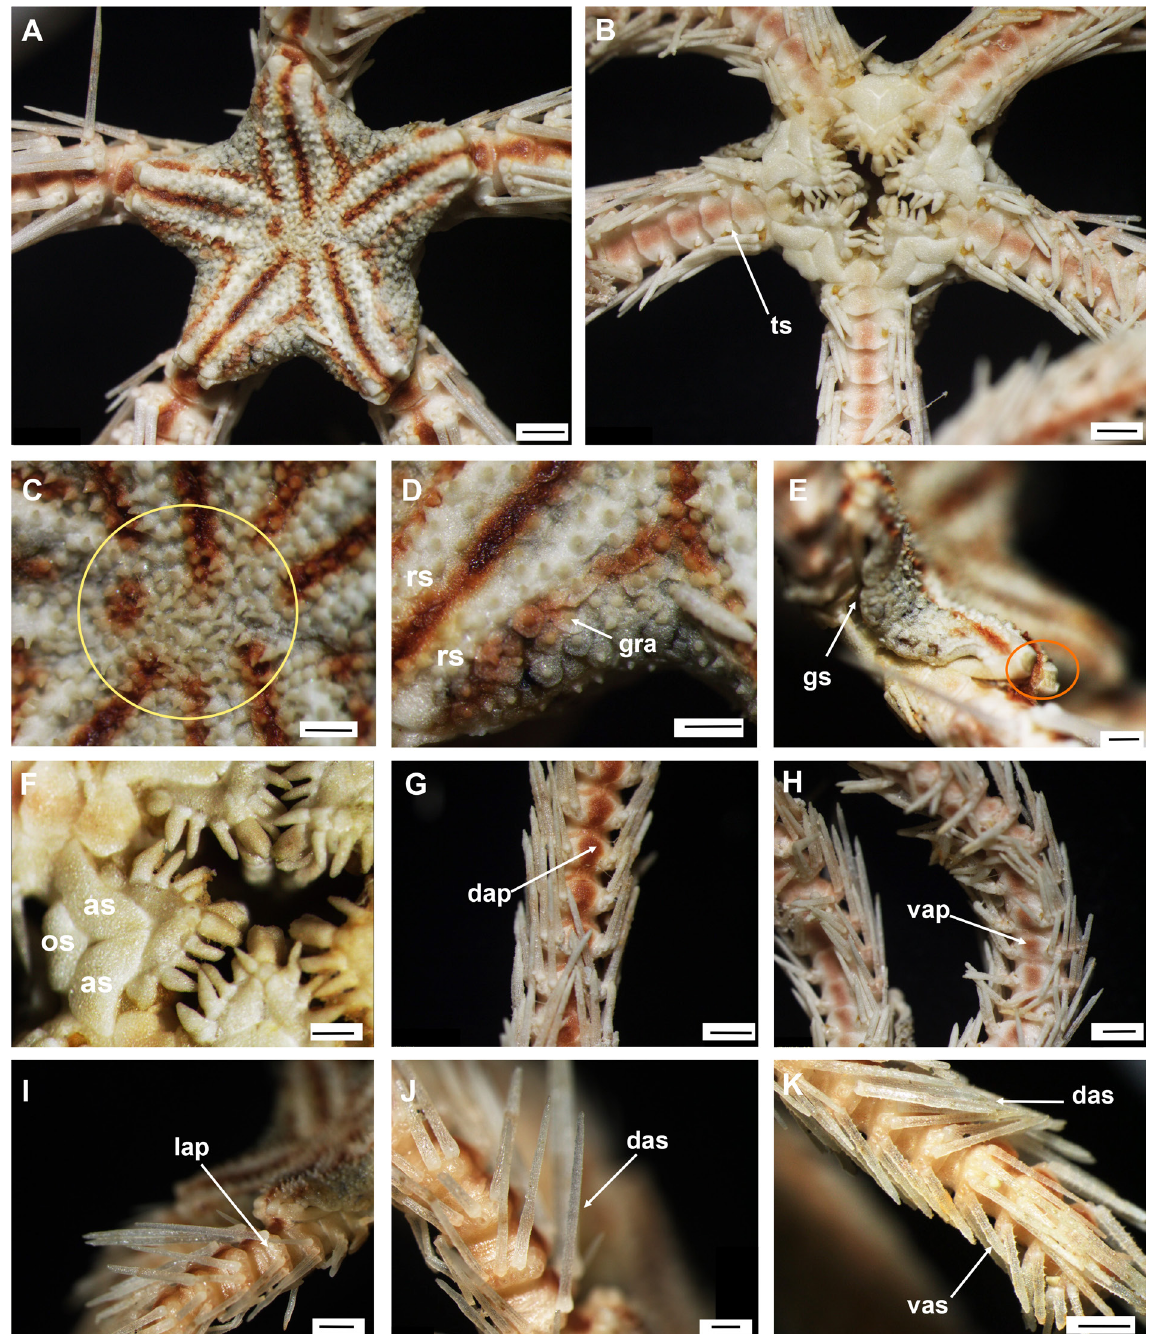
Fig. 31. Ophiacantha aster sp. nov., holotype (IDSSE EEB-SW0026). A . Dorsal disc. B . Ventral disc. C . Center of disc (elongated conical granules highlighted). D . Distal edges of radial shield. E . Lateral disc. F . Oral frame. G . Dorsal arm. H . Ventral arm. I–K . Lateral arm. Abbreviations: as = adoral shield; dap = dorsal arm plate; das = dorsal arm spine; gra = granule; gs = genital slit; lap = lateral arm plate; os = oral shield; rs = radial shield; ts = tentacle scale; vap = ventral arm plate; vas = ventral arm spine. Scale bars: A–B, G–K = 1 mm; C–F = 500